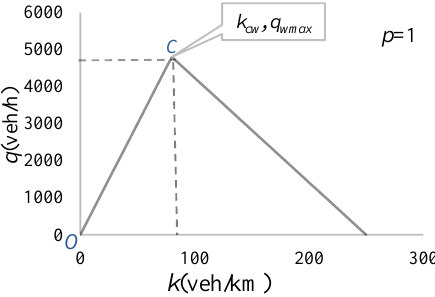
Figure 3. Flow-density diagram when p =